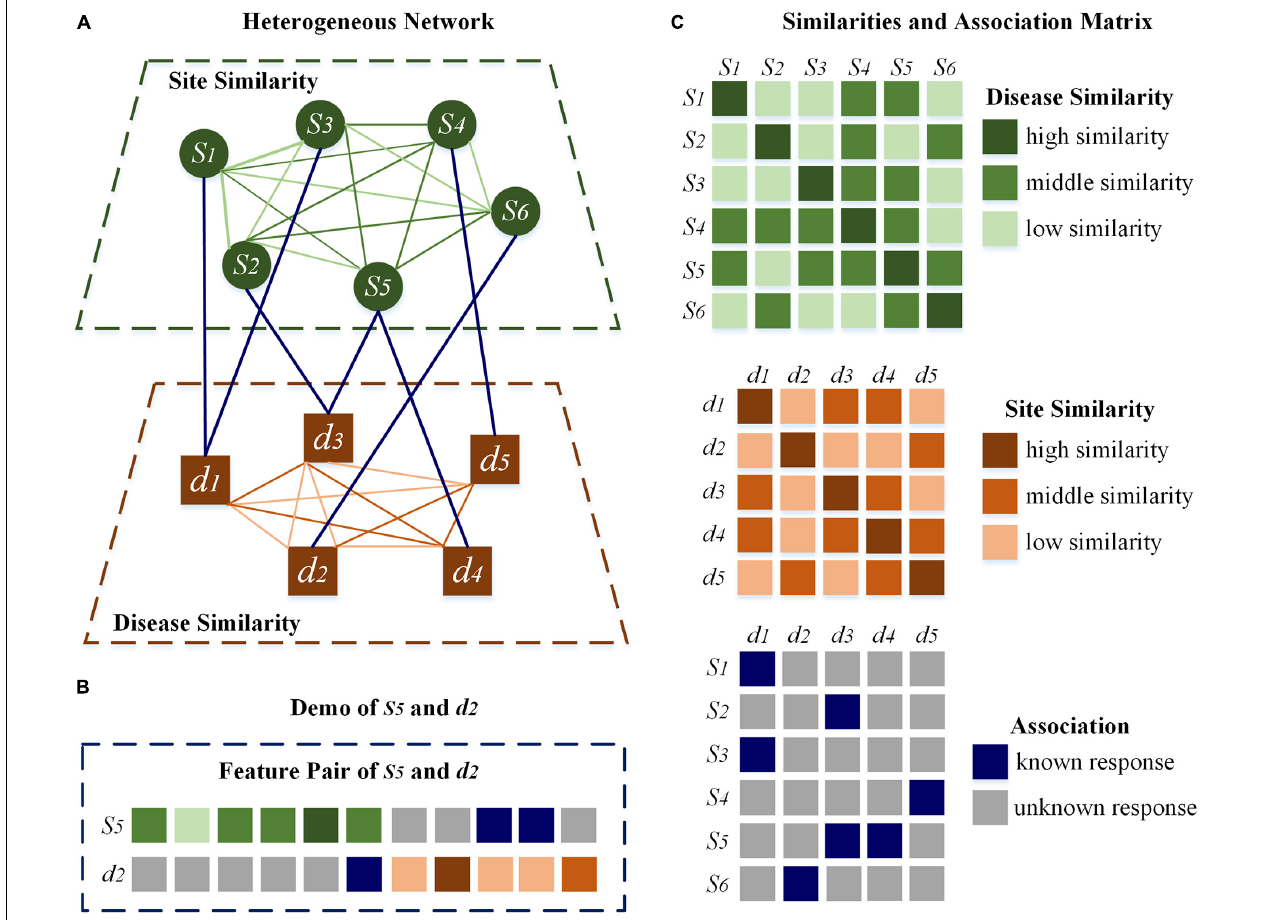
FIGURE 2 | Heterogeneous network and feature pair. (A) The heterogeneous network. (B) The demo of s 5 and d 2 . (C) The related matrixes